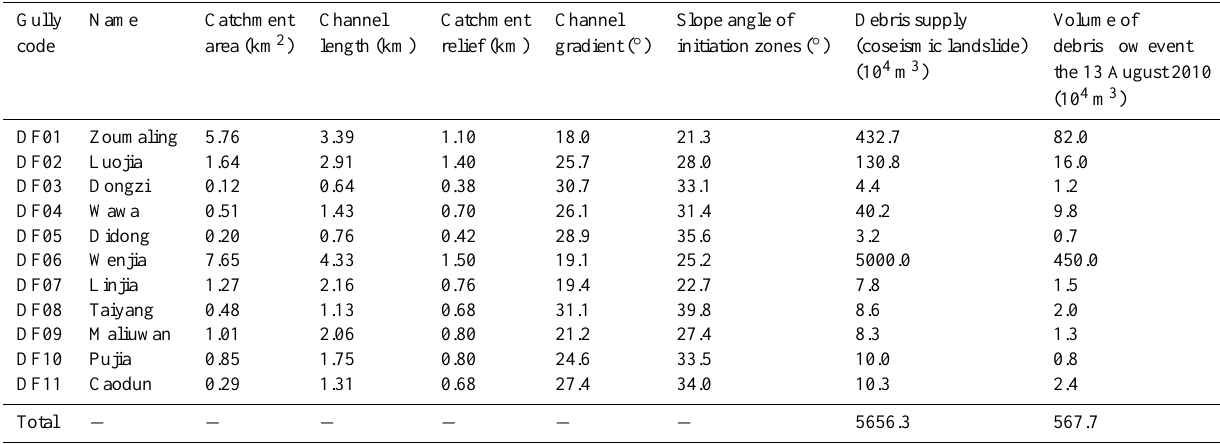
Table 1. Basic data for 11 debris flow gullies around Qingping. Gully